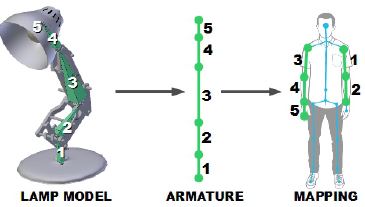
Figure 3. Mapping of the human skeleton onto the armature used to animate a Pixar-like lamp (a video is available at http:// youtu.be/iEuT7pzdMqw ).